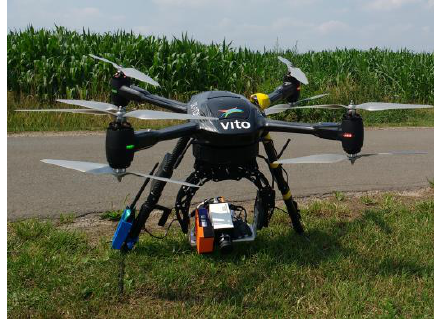
Figure 2. Cubert S 199 ButterflEYE LS mounted on the Aerialtronics Altura Zenith octocopter.